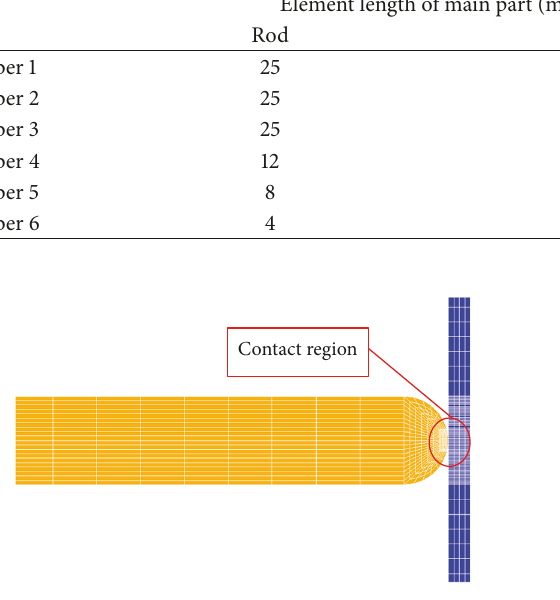
Figure 6: Spatial discretization of the contact bodies.